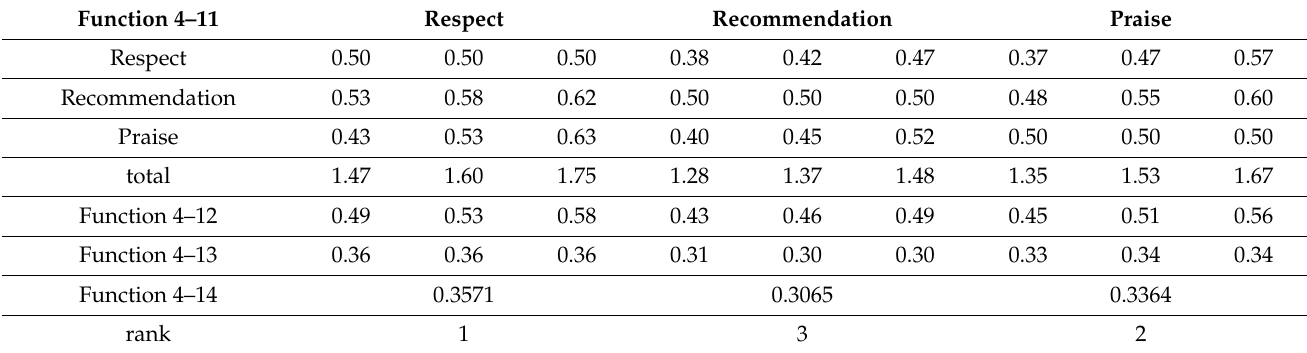
Table A4. Aviation companies’ weights of attributes of the social